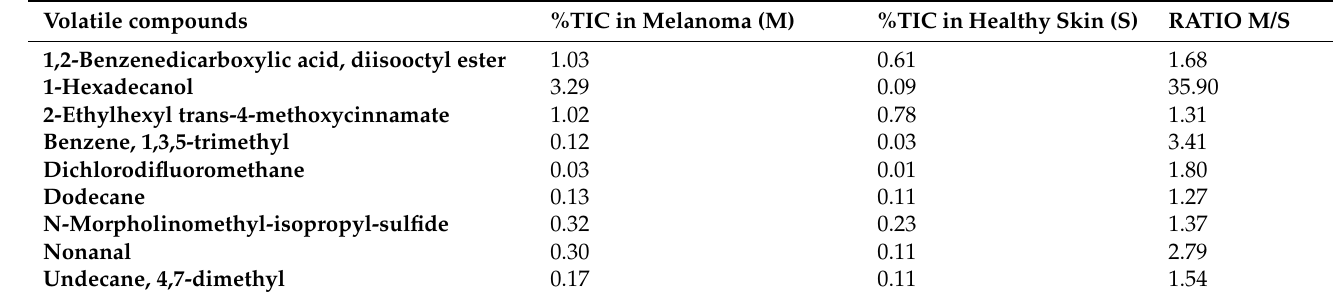
Table 2. Volatile compounds that showed ≥ 100% enrichment in melanoma compared to the healthy skin sample with the % Total Ion Count, (%TIC) and their ratios in Melanoma vs Skin and M/S